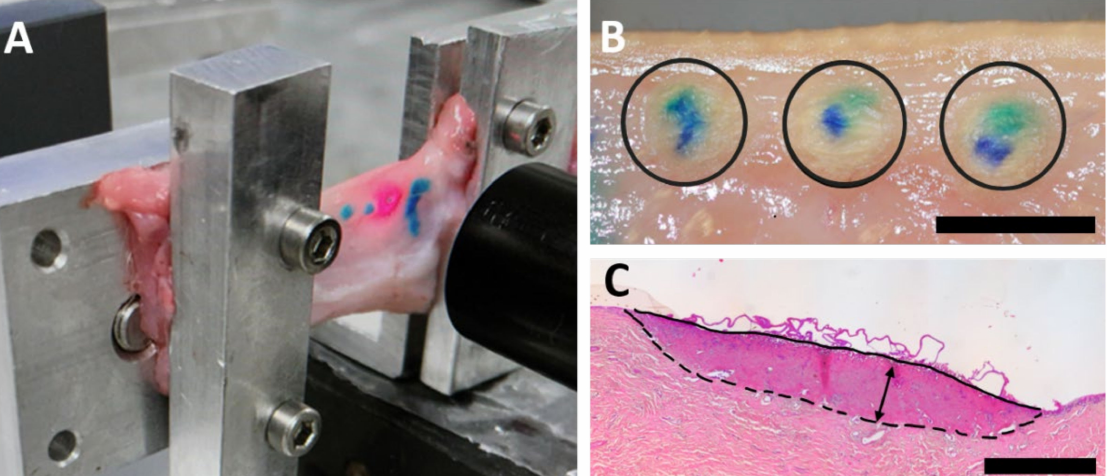
Figure 5. ( A ) Illustration of the porcine lower eyelid tissue fastened between clamps to mea- sure the tension during the experiment ( B ): Laser coagulations (black circles) after application. ( C ): Coagulation size was determined in HE staining. Arrow: Depth of coagulation, black line: coag- ulation diameter, epithelial side; dashed line: coagulation diameter, stromal side. Scale bars represent 5 mm ( B ) and 500 µ m ( C ).